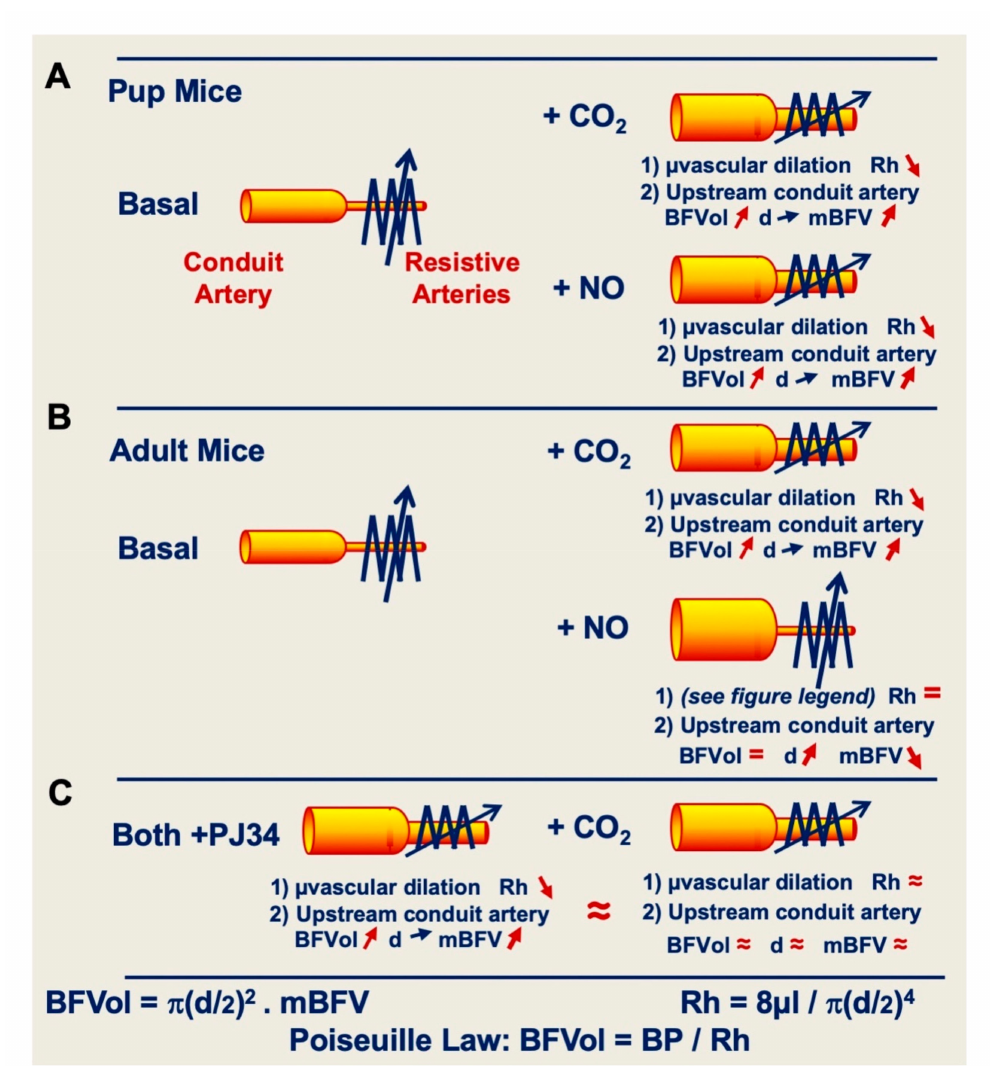
Figure 5. In an arterial network, the level of the hemodynamic resistance (Rh) inversely sets the value of the blood flow volume (BFVol) in the upstream conduit artery at each level of arterial blood pressure (BP) through the Poiseuille law. The level of the Rh is dependent of the inner diameter (d) of arterioles (resistive arteries). The BFVol determined, the mean blood flow velocity (mBFV) is adapted in relation to the section of the conduit artery. In pup ( A ) and adult (B ) mice, CO 2 gas mixture exposure provokes an arteriolar dilation with the consecutive upstream increase in the BFVol. Even if the conduit artery moderately dilates (5–8%, endothelial function), mBFVs increase illustrative of the downstream arteriolar dilation (20–40%, endothelial function) mediated by the metabolic command, representative of the cerebral vasoreactivity and the cerebral vasodilation reserve. In adults ( B ), an exogenous NO-donor provokes a dilation of the conduit artery without any modification of the level of Rh, thus of the BFVol, with a consecutive decrease in the mBFVs. In absence of metabolic modification, regulation of the microvascular tone is maintained by the sympathetic nervous system (SNS), which counteracts the NO-mediated arteriolar dilation. In the developing brain ( A ), SNS is immature and does not counteract the exogenous NO-mediated arteriolar dilation with the consecutive increase in BFVols and BFVs in the upstream conduit artery. In both adults and pup mice ( C ), 1 h after PJ34 administration, arterioles dilate and the BFVol and the mBFV increase in the upstream conduit arteries by recruitment on the cerebral vasodilation reserve without any significant additional e ff ect under CO 2 . PJ34 by itself was able to increase cerebral BF by recruitment on the cerebral vasodilation reserve. + This increase is nitric oxide (NO) dependent under the activation of the Ca 2 -dependent